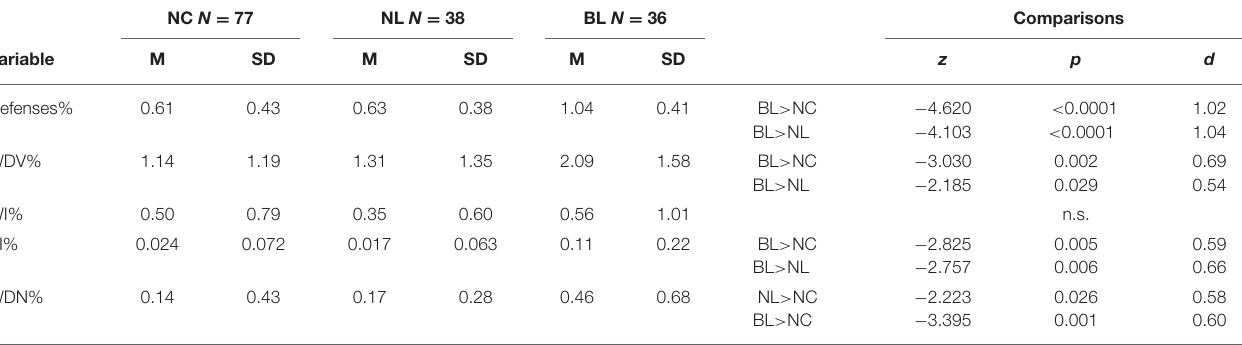
TABLE 3 | Comparisons between non-clinical and clinical groups on LDS variables (after converting the score for each defense to a percentage using the total number of responses eligible for coding on LDS as the denominator).